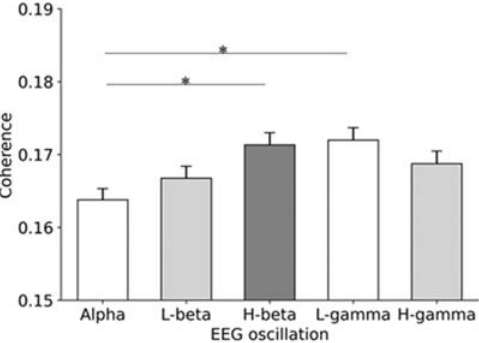
Figure 3. The mean ± SEM of the coherence values in alpha, low ‐ beta, high ‐ beta, low ‐ gamma, and high ‐ gamma oscillations with passive movement rhythm. The coherence value of the alpha band was significantly lower than those of the high ‐ beta and low ‐ gamma bands (alpha vs. high beta, p = 0.013; alpha vs. low gamma, p = 0.005). SEM, standard error of the mean: L ‐ beta, low beta; H ‐ beta, high beta; L ‐ gamma, low gamma; H ‐ gamma, high gamma. *: p < 0.05.